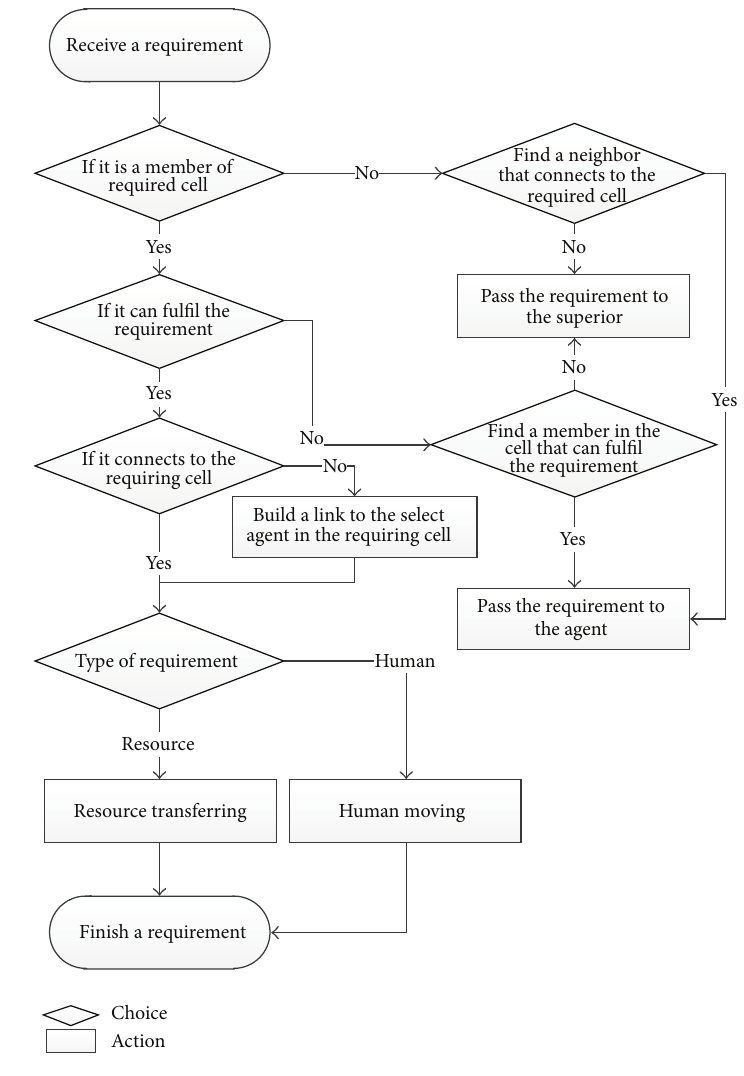
Figure 3: The response mechanism of agent to a requirement.